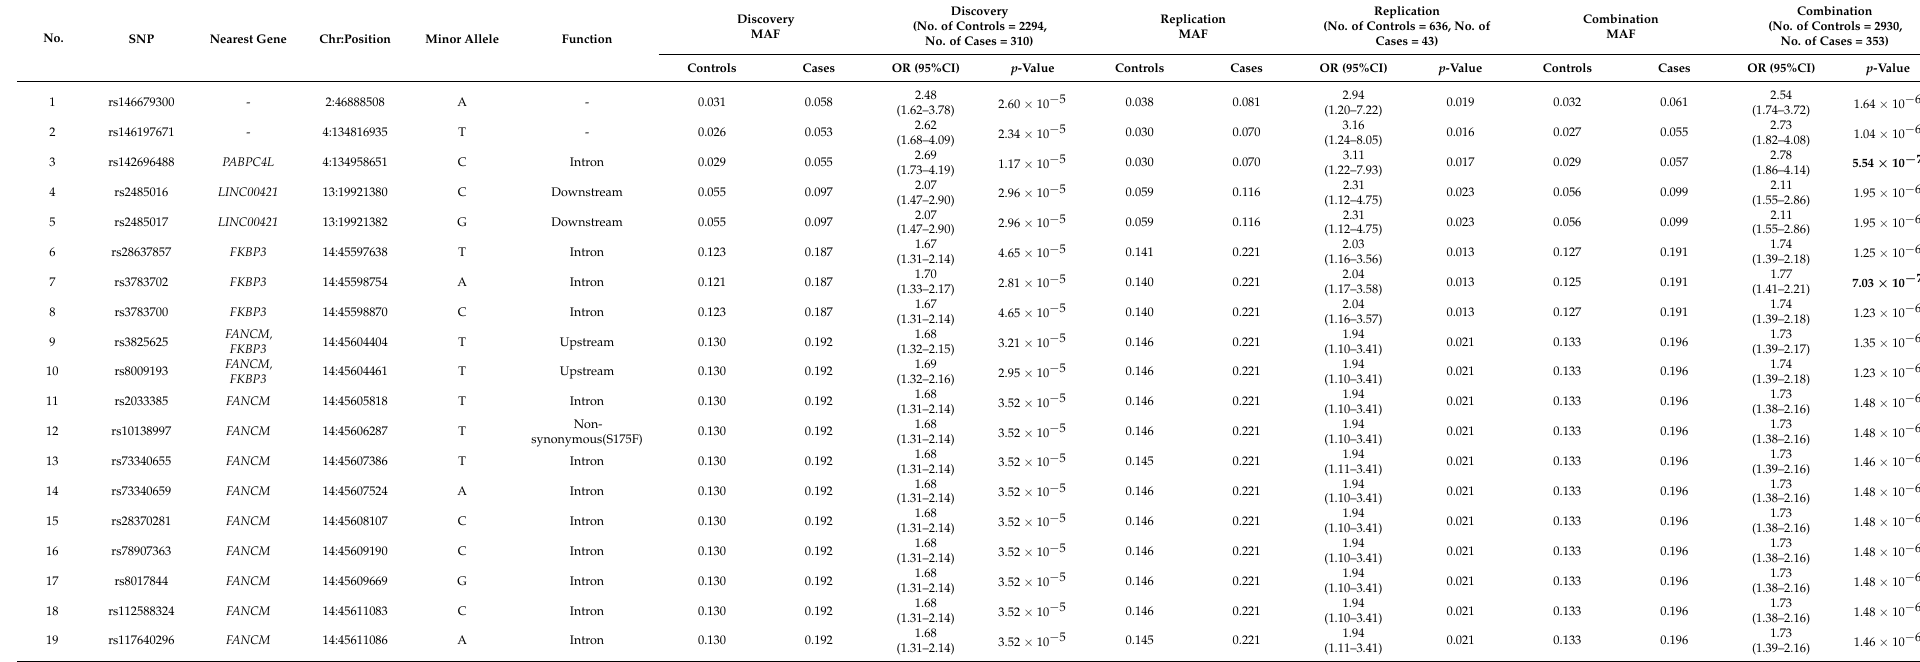
Table 2. Loci associated with hypertensive kidney disease in Korean